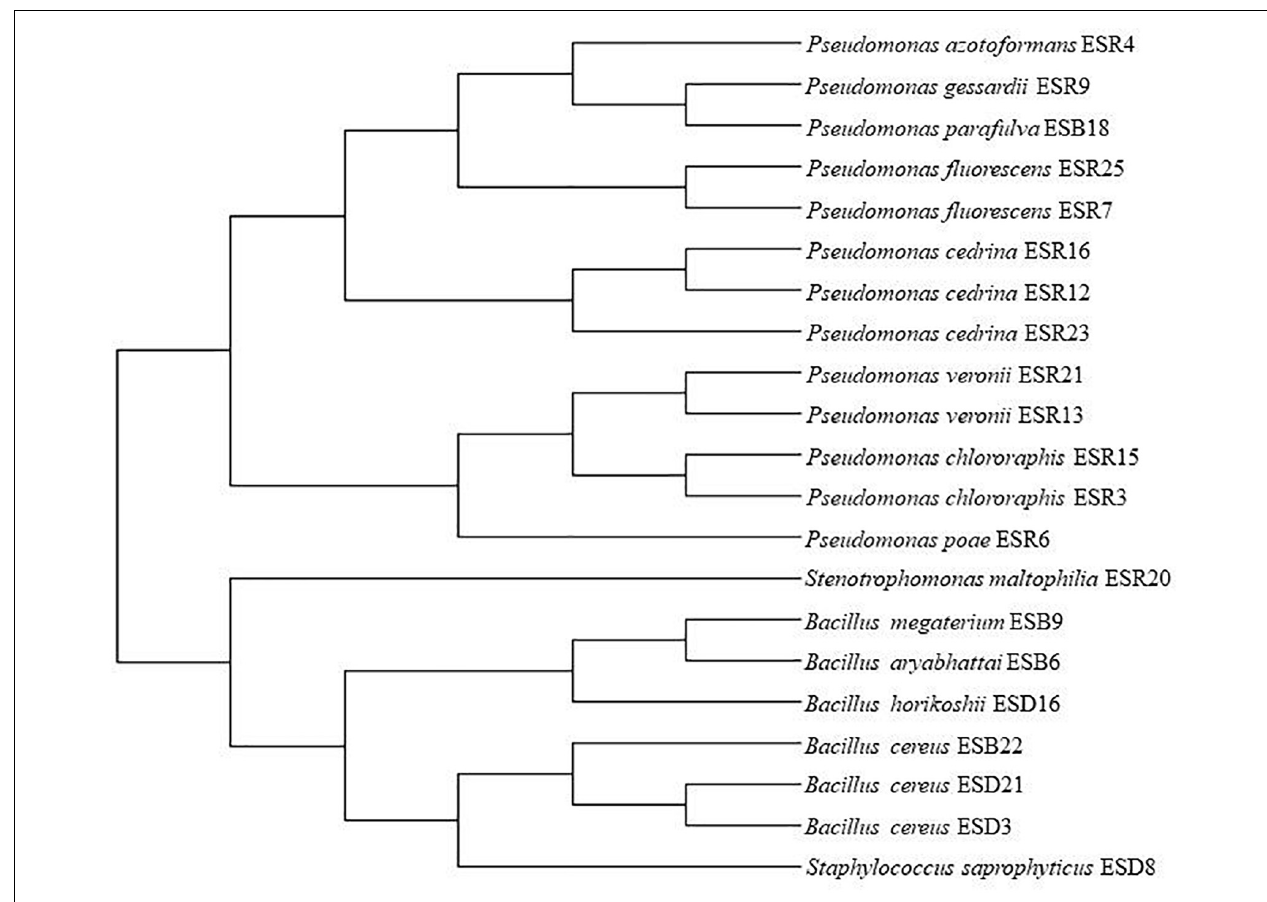
FIGURE 2 | Phylogenetic tree. MUSCLE alignment and maximum likelihood (PhyML) method were used for tree generation with gBlock used for alignment